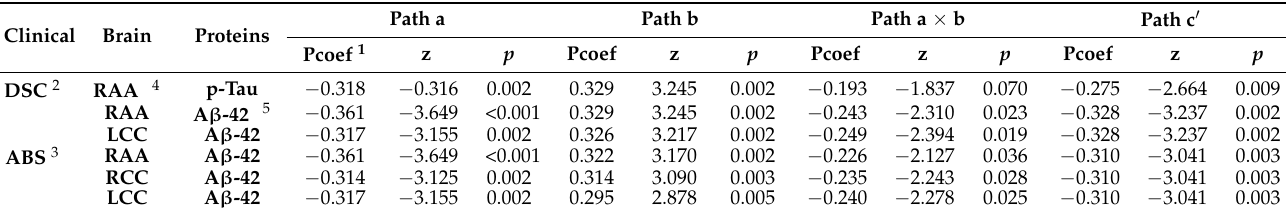
Table 4. Potential brain mediators of plasma misfolded proteins on the cognitive functions. The corresponding statistical results of each path and mediation effect between the misfolded proteins (independent variable), cognitive functions (dependent variable), and brain areas (mediators) are described in terms of corresponding path coefficient, z value, and p